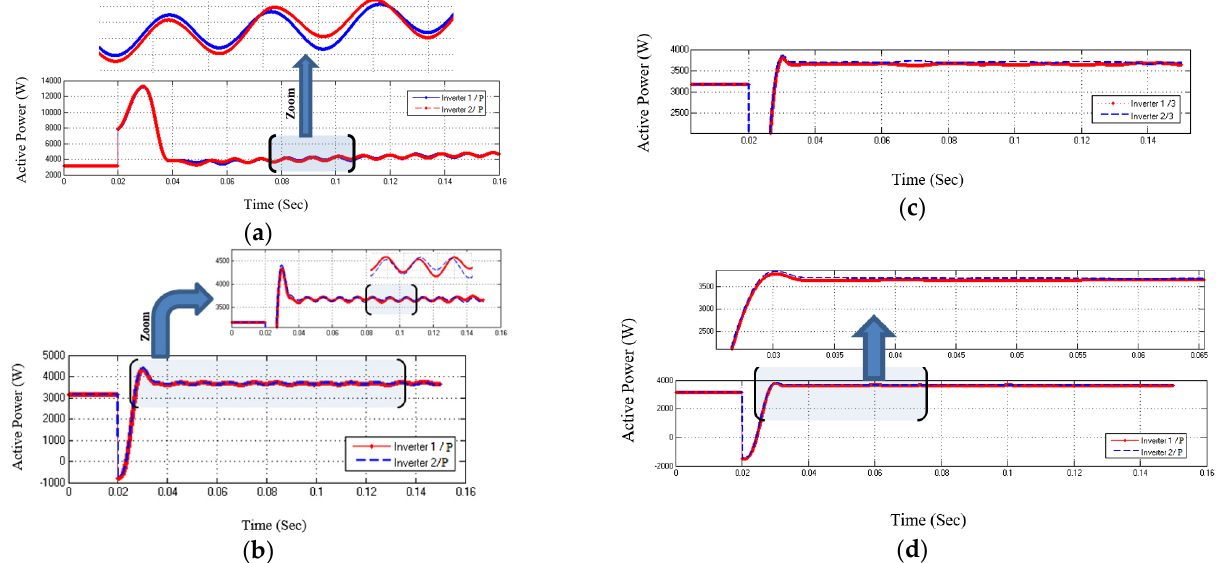
Figure 15. Active power sharing between inverter 1 and inverter 2 by droop control using: ( a ) con- ventional control; ( b ) PSO algorithm; ( c ) ABC algorithm; and ( d ) H ∞ with the ABC algorithm. Table 3. Comparison of power sharing with different algorithms.